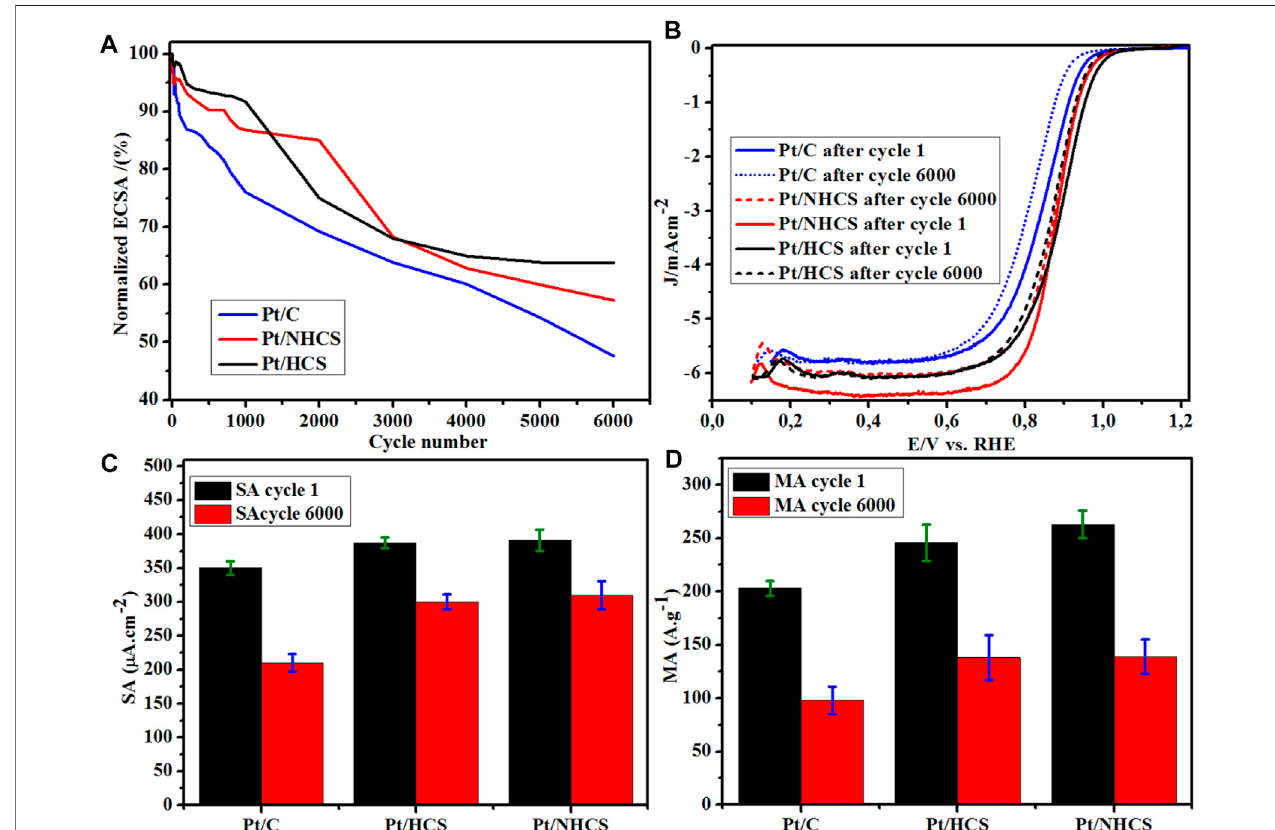
FIGURE 7 | (A) Normalized ECSA% degradation of the catalysts, (B) catalyst LSVs before and after durability studies for the Pt/HCSs, Pt/NHCSs and the commercial benchmark Pt/C catalysts, (C) SA data before and after durability studies, (D) MA data before and after durability studies.